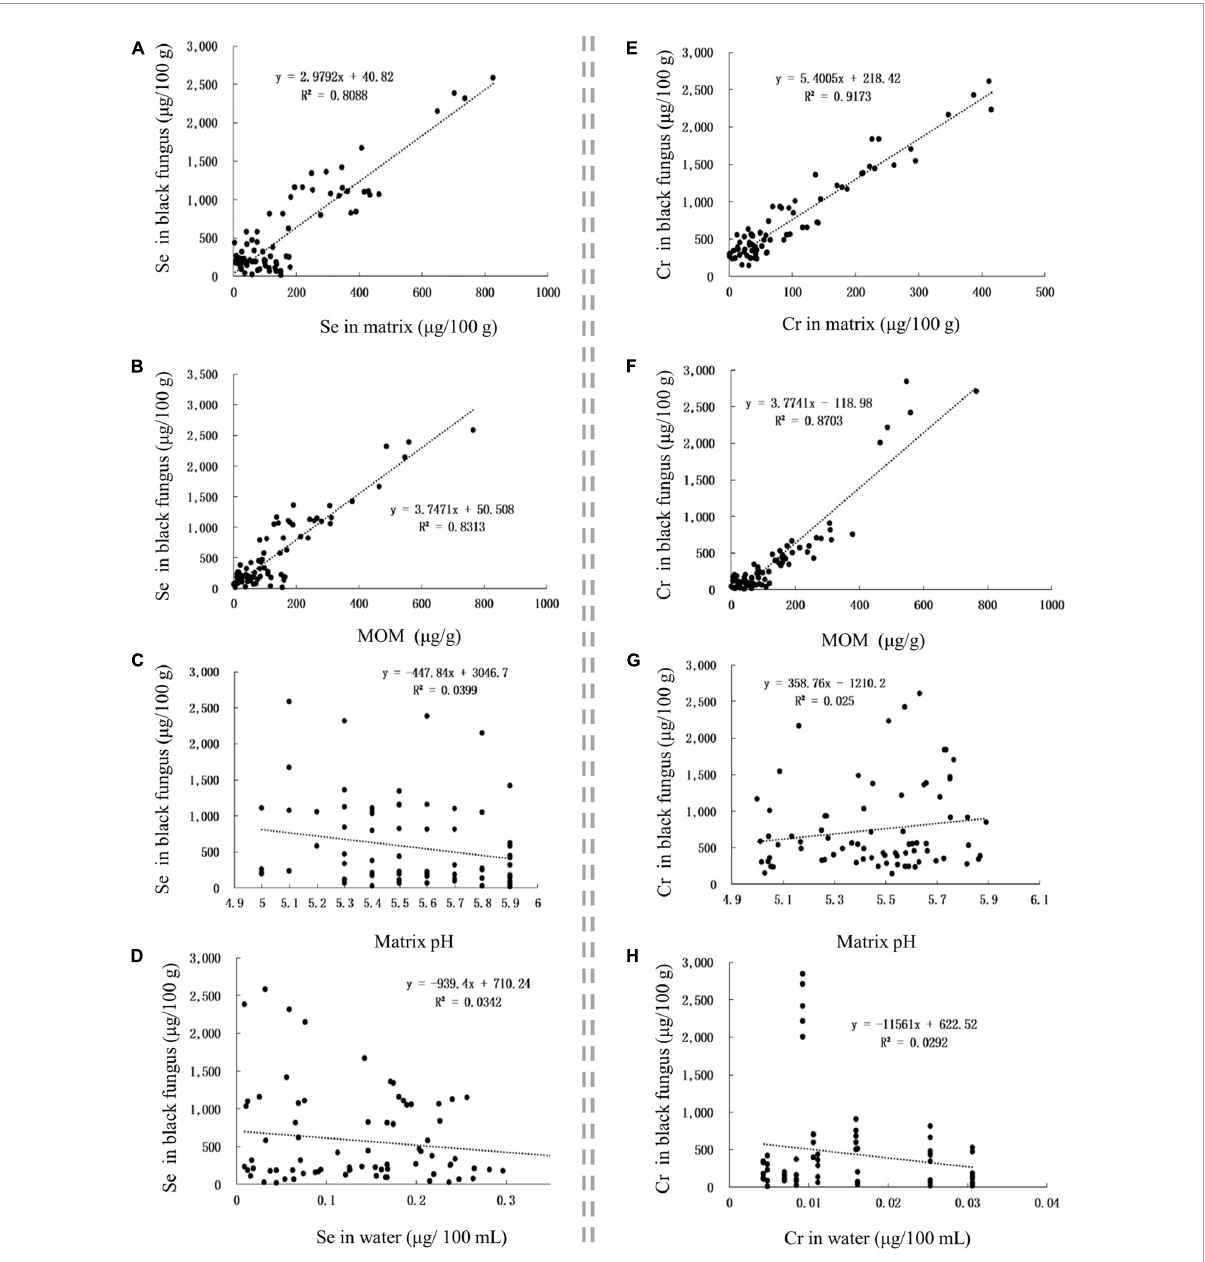
FIGURE5 The influence of factors on Se and Cr contents in black fungus. (A–D) The influence of Se content in matrix, MOM, matrix pH, and Se content in water on Se content in black fungus, respectively. (E–H) , The influence of Cr content in matrix, MOM, matrix pH, and Cr content in water on Cr content in black fungus,